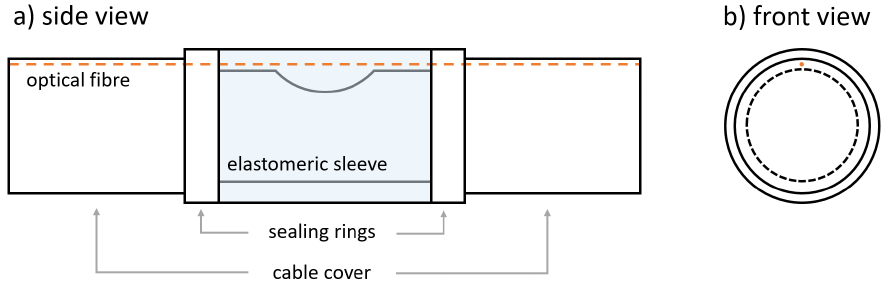
Figure 9. Schematic of the fibre-optic pressure sensor described in [68].